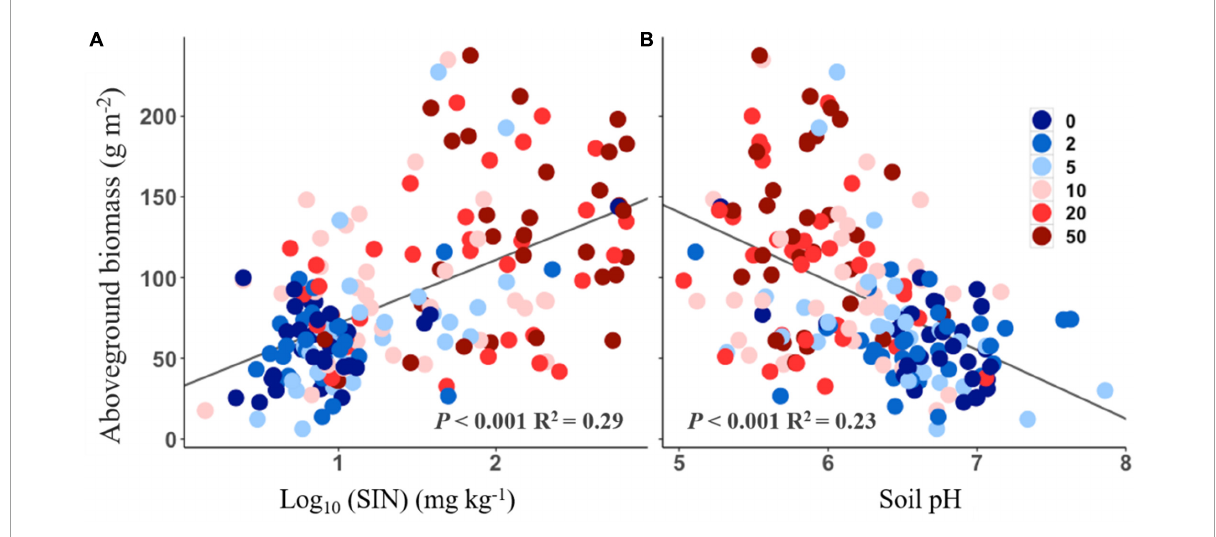
FIGURE4 Relationships between aboveground biomass and soil inorganic nitrogen (SIN, log 10 -transformed, A ) and soil pH (B) .